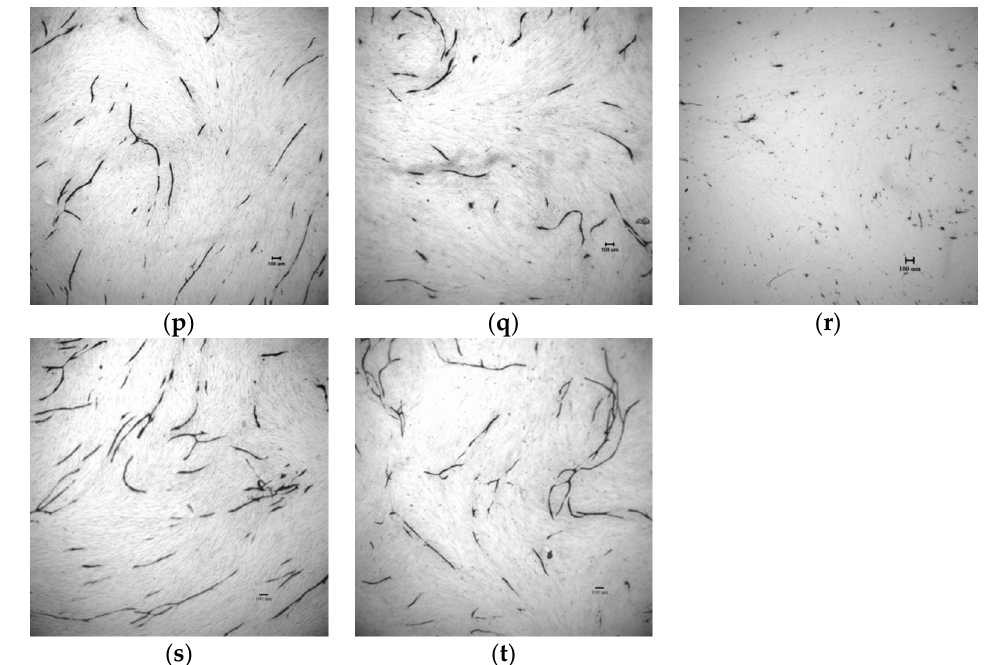
Figure 5. Compounds 8 – 12 inhibited tube formation induced by VEGF. Reprehensive photographs of tube formation ( a ) solvent control; ( b ) VEGFR 10 ng/mL and 70 μ M of suramin; ( c ) VEGF 10 ng/mL and 0.50 μ M of sunitinib; ( d ) VEGF 10 ng/mL and 0.25 μ M of sunitinib; ( e ) VEGF 10 ng/mL and 0.10 μ M of sunitinib; ( f ) VEGF 10 ng/mL and 0.50 μ M of 8 ; ( g ) VEGF 10 ng/mL and 0.25 μ M of 8 ; ( h ) VEGF 10 ng/mL and 0.10 μ M of 8 ; ( i ) VEGF 10 ng/mL and 0.50 μ M of 9 ; ( j ) VEGF 10 ng/mL and 0.25 μ M of 9 ; ( k ) VEGF 10 ng/mL and 0.10 μ M of 9 ; ( l ) VEGF 10 ng/mL and 0.50 μ M of 10 ; ( m ) VEGF 10 ng/mL and 0.25 μ M of 10 ; ( n ) VEGF 10 ng/mL and 0.10 μ M of 10 ; ( o ) VEGF 10 ng/mL and 0.50 μ M of 11 ; ( p ) VEGF 10 ng/mL and 0.25 μ M of 11 ; ( q ) VEGF 10 ng/mL and 0.10 μ M of 11 ; ( r ) VEGF 10 ng/mL and 0.50 μ M of 12 ; ( s ) VEGF 10 ng/mL and 0.25 μ M of 12 ; ( t )VEGF 10 ng/mL and 0.10 μ M of 12 . Scale bar = 100 μ m. Table 3. IC 50 of in vitro VEGF-induced tube formation by 8 – 12 and sunitinib. Compd.